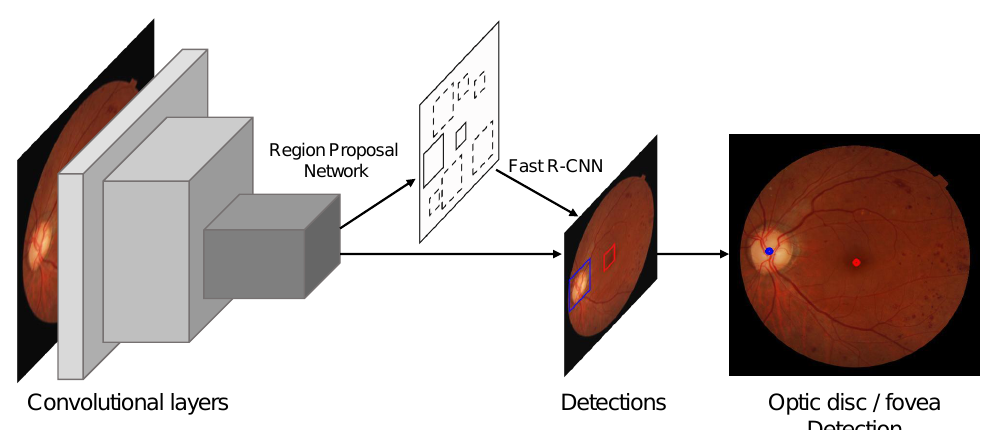
Figure 2. Network diagram for disc and fovea detection. We apply the Faster R-CNN [14] method which is a two-step method comprising a region proposal network for detecting object candidates and a Fast RCNN network for classifying and localizing the bounding boxes for